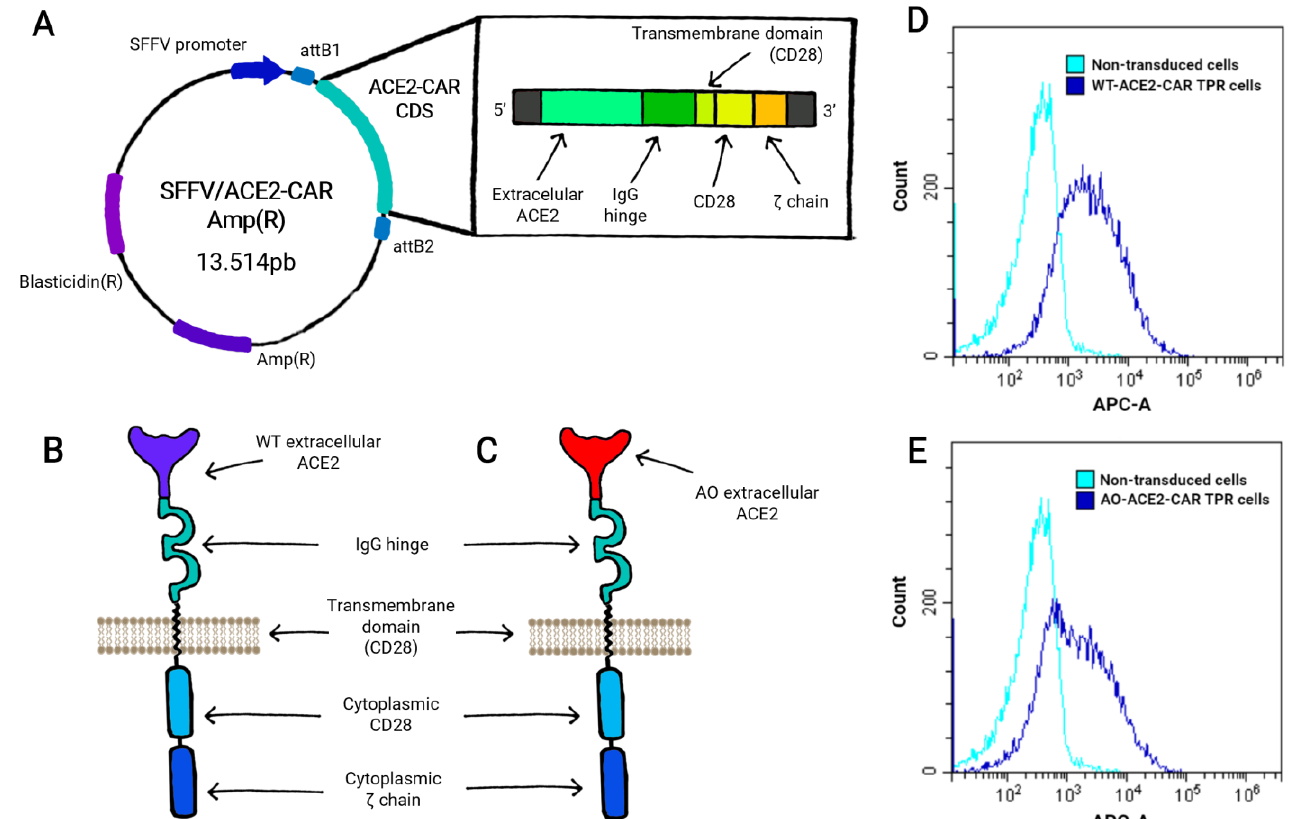
Figure 1. ACE2-CAR design and expression. Generic diagram of the expression vector SFFV/ACE2- CAR Amp(R) ( A ), which was the same for both WT- ( B ) and AO- ( C ) ACE2-CAR molecules, only differing at the ACE2 extracellular domain. Expression of both CAR-like constructs onto Jurkat-TPR cells was detected by staining with anti-IgG, recognizing the hinge region that was unchanged between WT- ( D ) and AO- ( E ) ACE2-CAR.